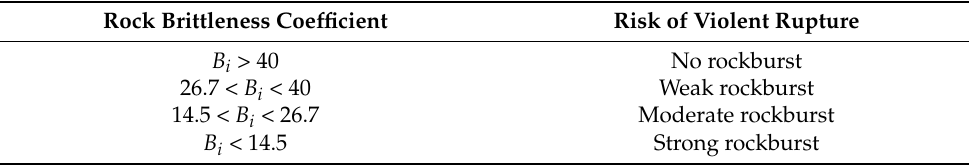
Table 6. Rockburst intensity depending on the brittleness coefficient [149].